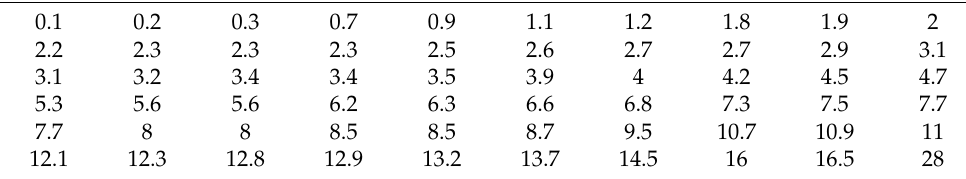
Table 14. Bank B’s customer waiting time.